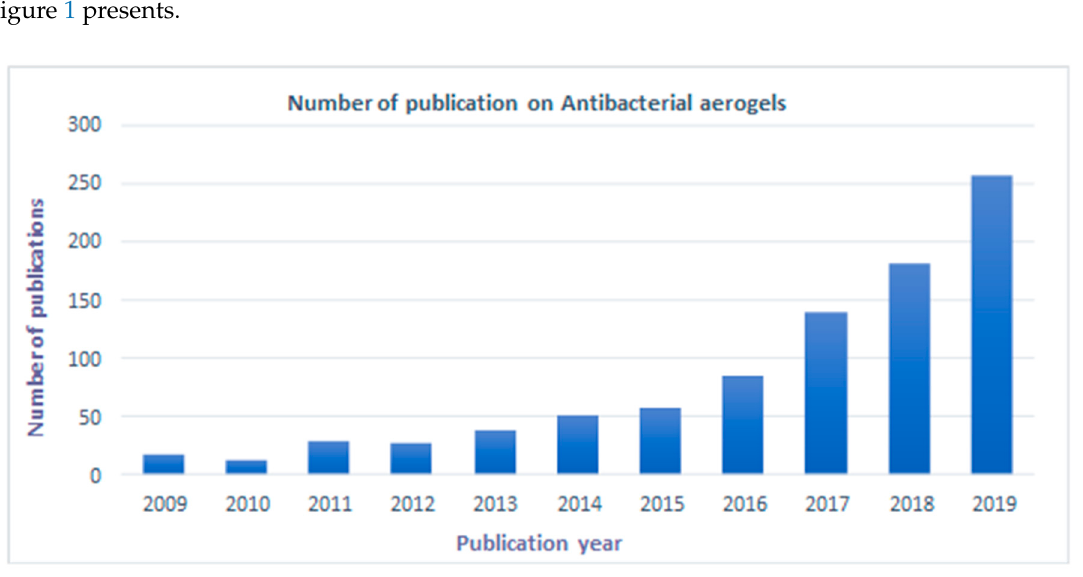
Figure 1. Number of scientific publications in the last ten years, contributing to the subject “biopolymers aerogels” by year (Search conducted through Science Direct on 9 September 2020 (From 2009 to 2019)).